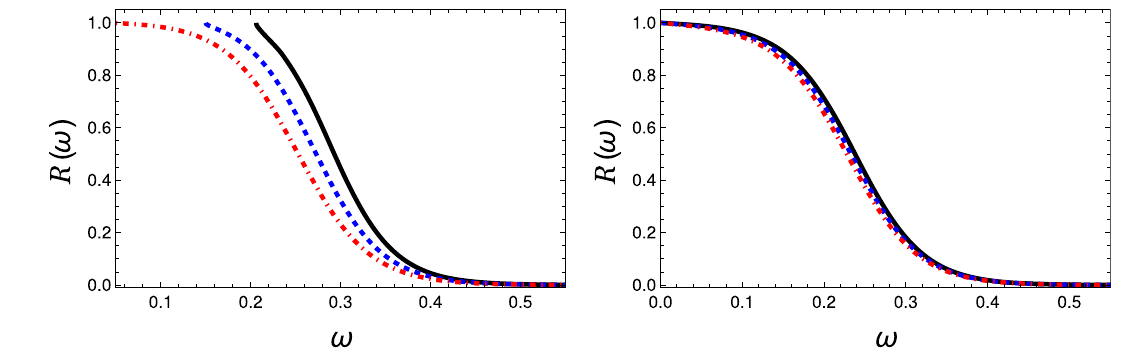
Fig. 2 Reflection coefficient R as a function of ω for two different regimes regarding the non-minimal coupling: (1) when 0 ≤ ξ < ξ c (left) and (2) when ξ ≥ ξ c (right). Left panel: reflection coefficient ver- sus frequency for ξ = 0 . 04 (solid black line), ξ = 0 . 08 (dashed blue